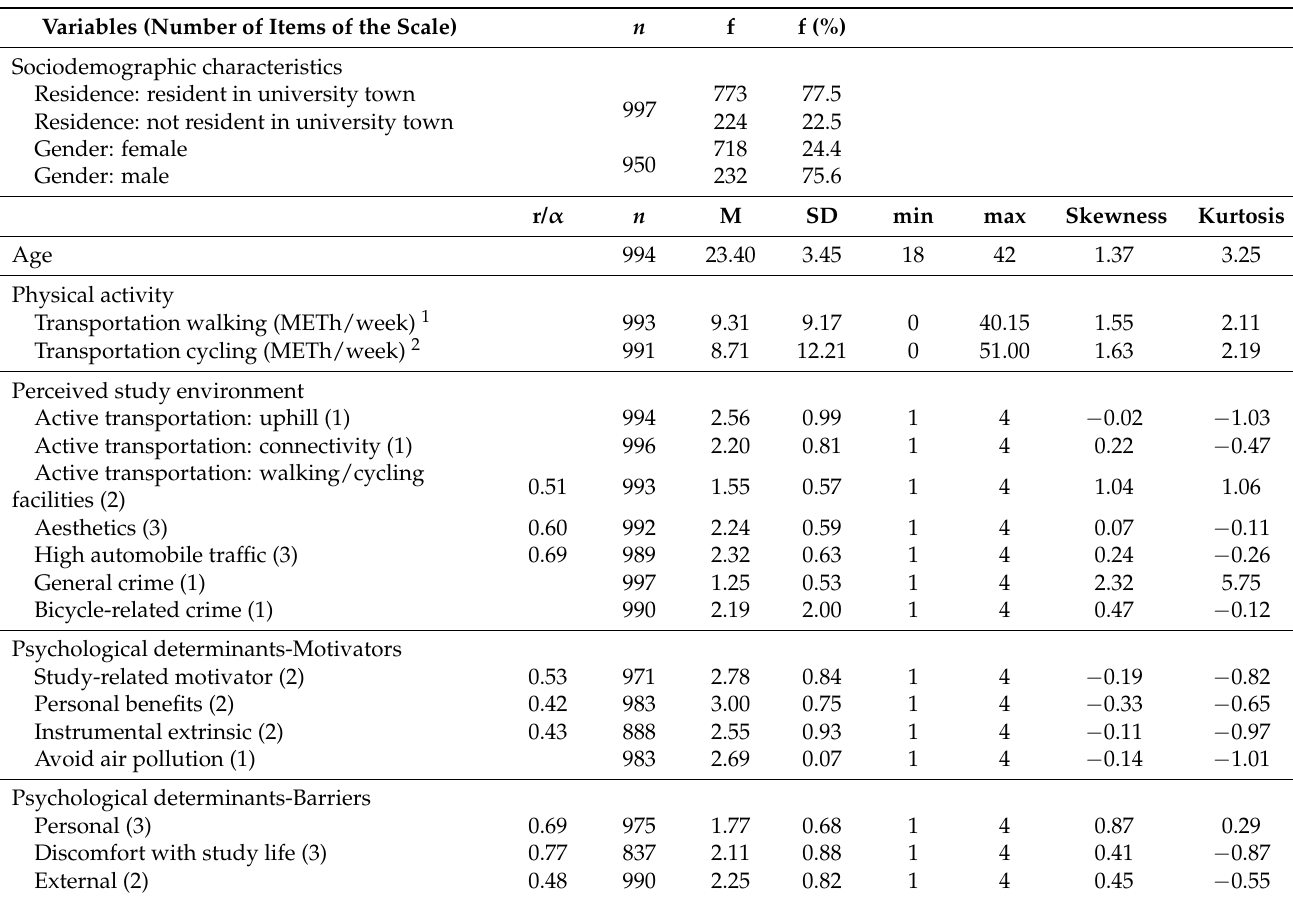
Table 1. Overview of the sample as well as of the study variables according to physical activity (dependent variables), perceived study environment, and personal motivators for and barriers to